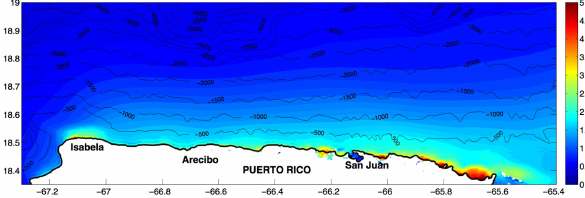
Fig. 15. Bathymetry (black isobaths in meter) and maximum sur- face elevation and (coastal) inundation (color scale in meters) along PRNS, simulated for the M =8.7 co-seismic tsunami source (using a 15 00 model grid, with the 3 00 topography and bathymetry depicted in Fig. 5). The thick black line marks the mean coastline location prior to tsunami arrival (zero elevation).